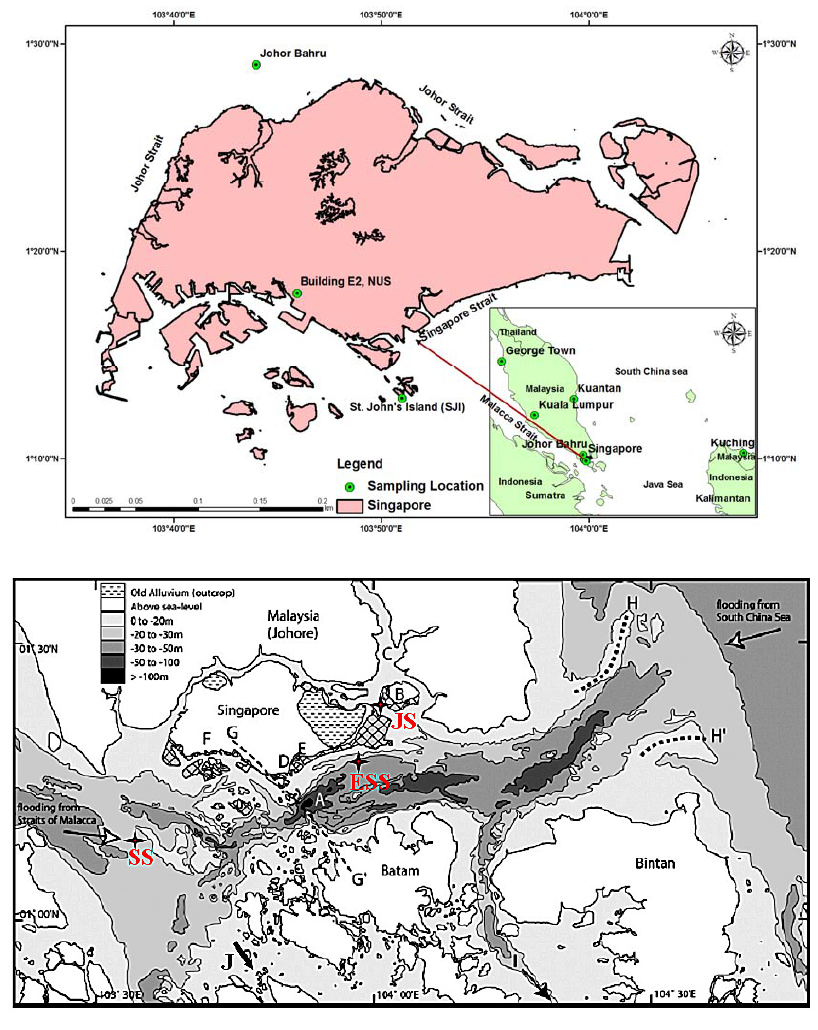
Fig. 1. (a) Map showing sampling locations (NUS and SJI) in Singapore and surrounding regions; (b) general features and high-resolution bathymetry of Singapore seawaters (Admiralty Chart 2403 “Singapore Strait and Eastern Approaches”) covering NEUTRO model domain (Courtesy from Chan et al., 2006). Note: cross-hatching:Reclaimed areas in Singapore, A: The Singapore Deeps, B: Pulau Tekong, C: Johor River, D: Singapore Central Business District, E: Bedok, F: Jurong; G-G’: Fault, H-H’: splays of sediment, I: Riau Strait, J: Selat Durian and SS, ESS and JS: observation